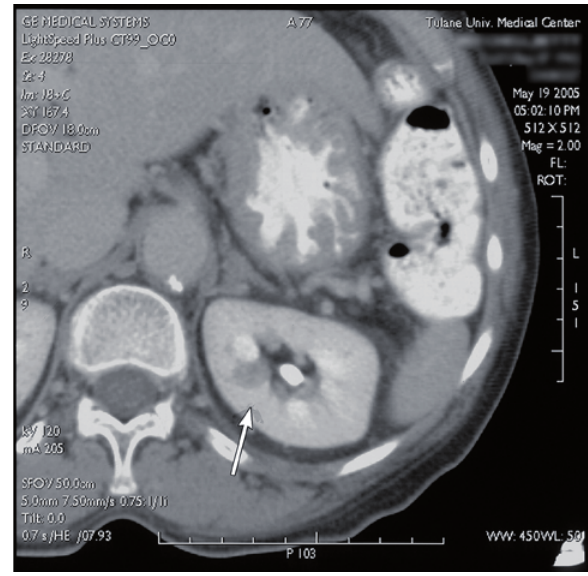
Figure 2 - lateral extension of the gas-dissection in the pre-vesical space.